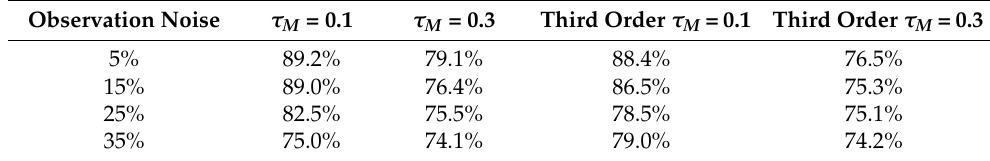
Table 5. Success rate under uncertainty disturbances.